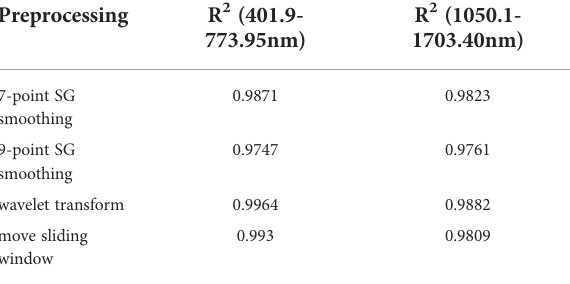
TABLE 1 Comparison of R-square (R 2 ) after preprocessing.